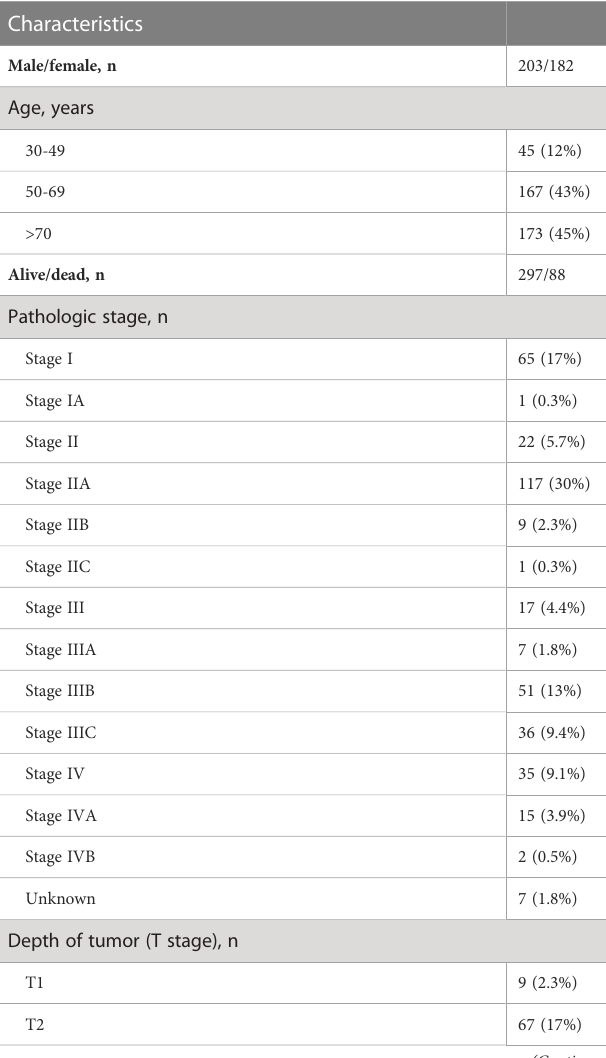
TABLE 1 The clinical information of the TCGA-COAD cohort (selected 385 patients).